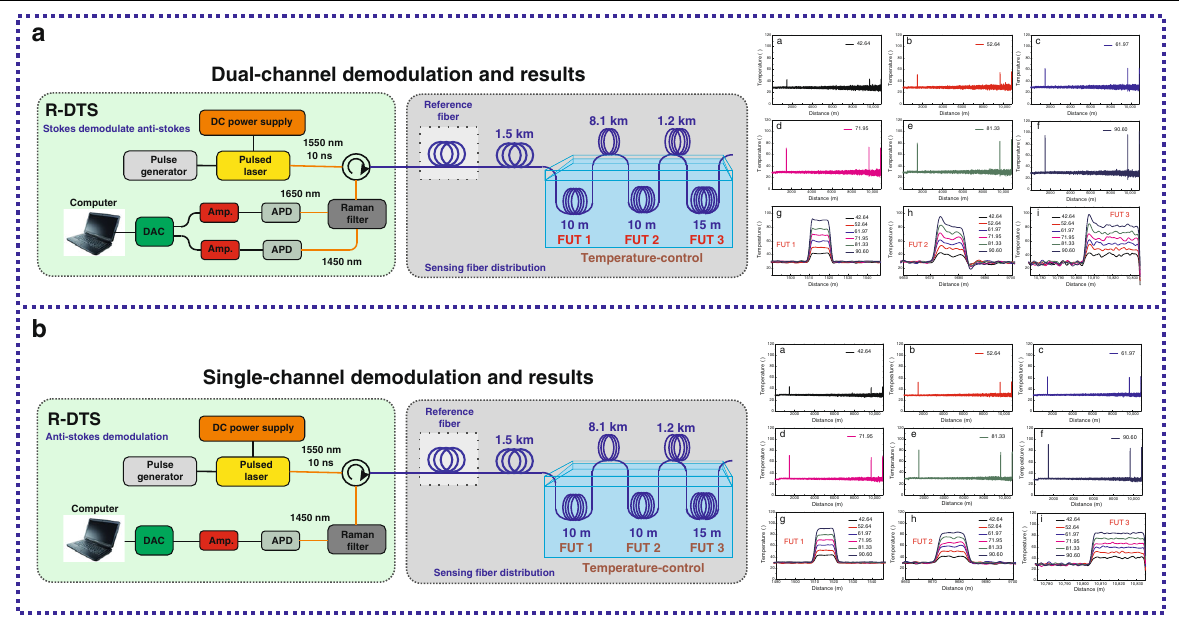
Fig. 1 Experimental setup and results of the Raman distributed optical fi ber sensor. a Experimental setup and typical results of the dual- channel demodulation principle. b Experimental setup and typical results of the single-channel demodulation